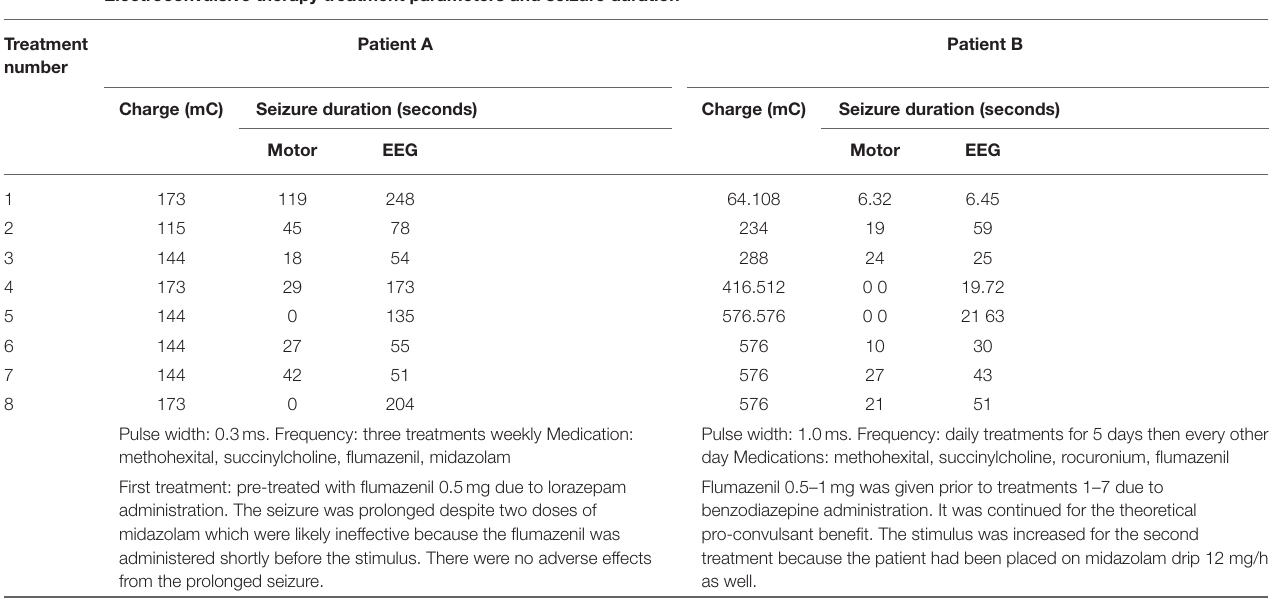
Pulse width: 1.0ms. Frequency: daily treatments for 5 days then every other day Medications: methohexital, succinylcholine, rocuronium, flumazenil